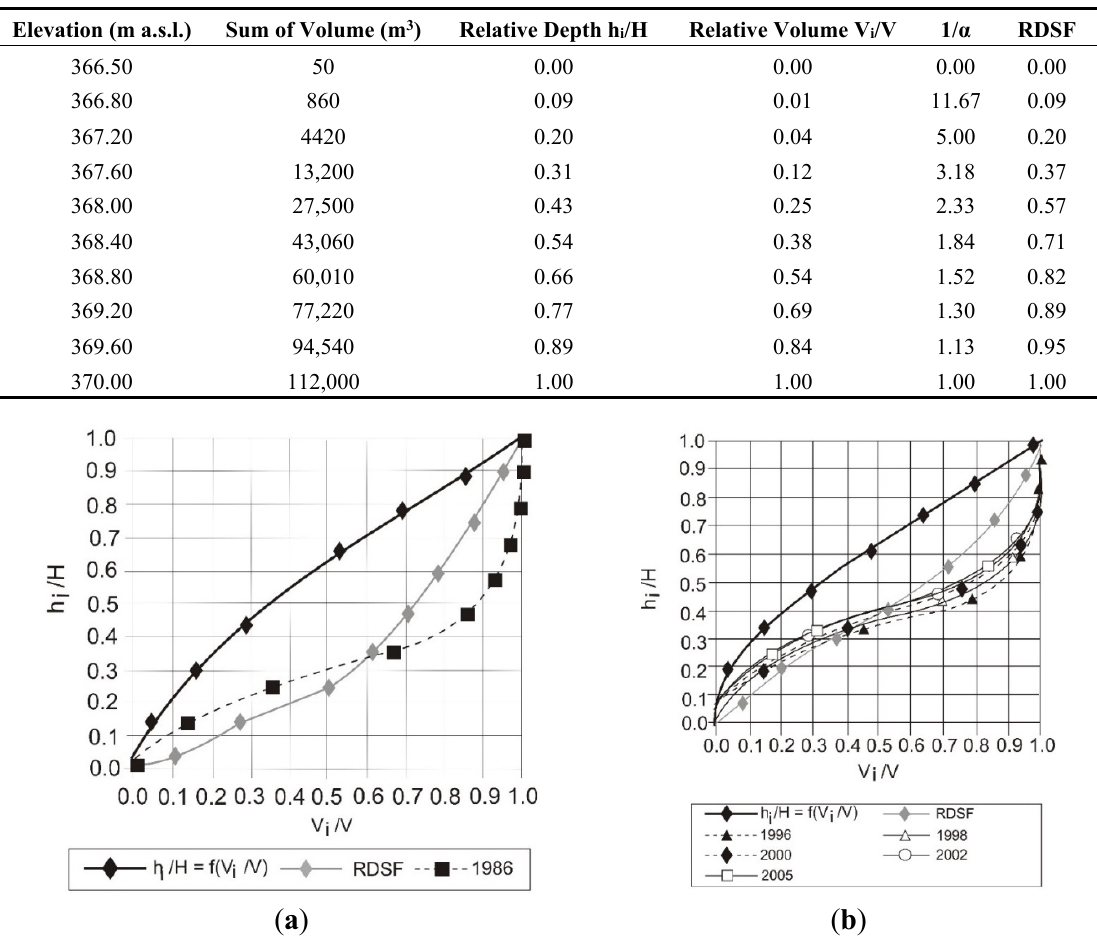
Table 8. Relative Depth Shape Function for different elevations from the reservoir bed for Krempna reservoir after dredging.